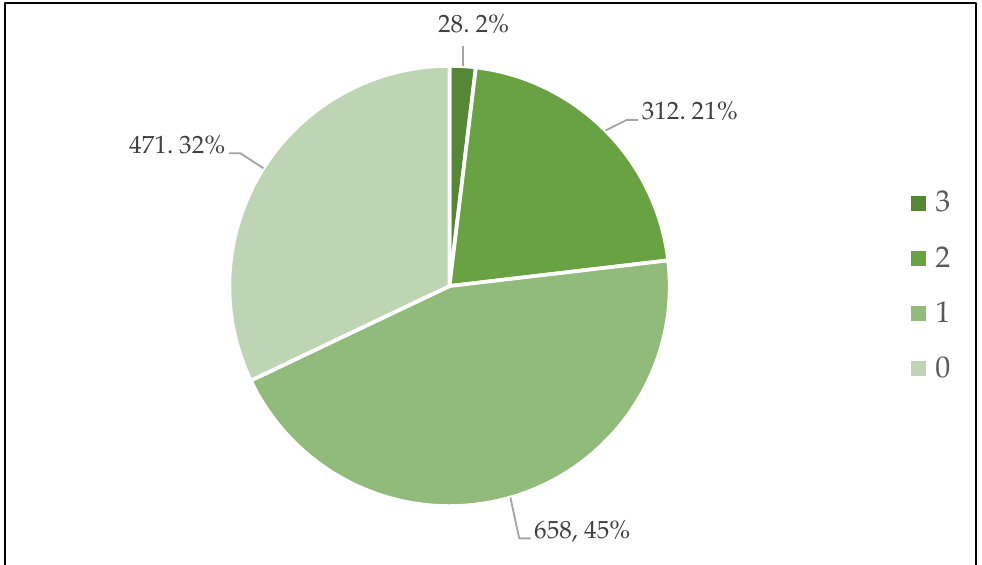
Figure 1. Levels of participants’ knowledge about the Dual Carbon Goals. Notes: The numbers on the pie chart read as ‘number of respondents, percentage’. The list of numbers on the right side is the aggregate of scores respondents received while answering the three